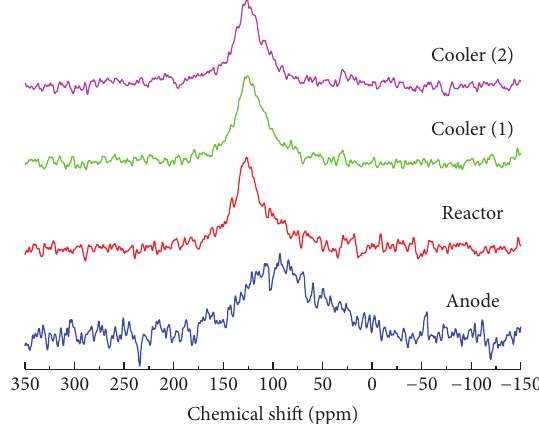
Figure 7: 13 C DP/MAS NMR spectra of the carbon residues collected at different points in the Ar plasma apparatus.